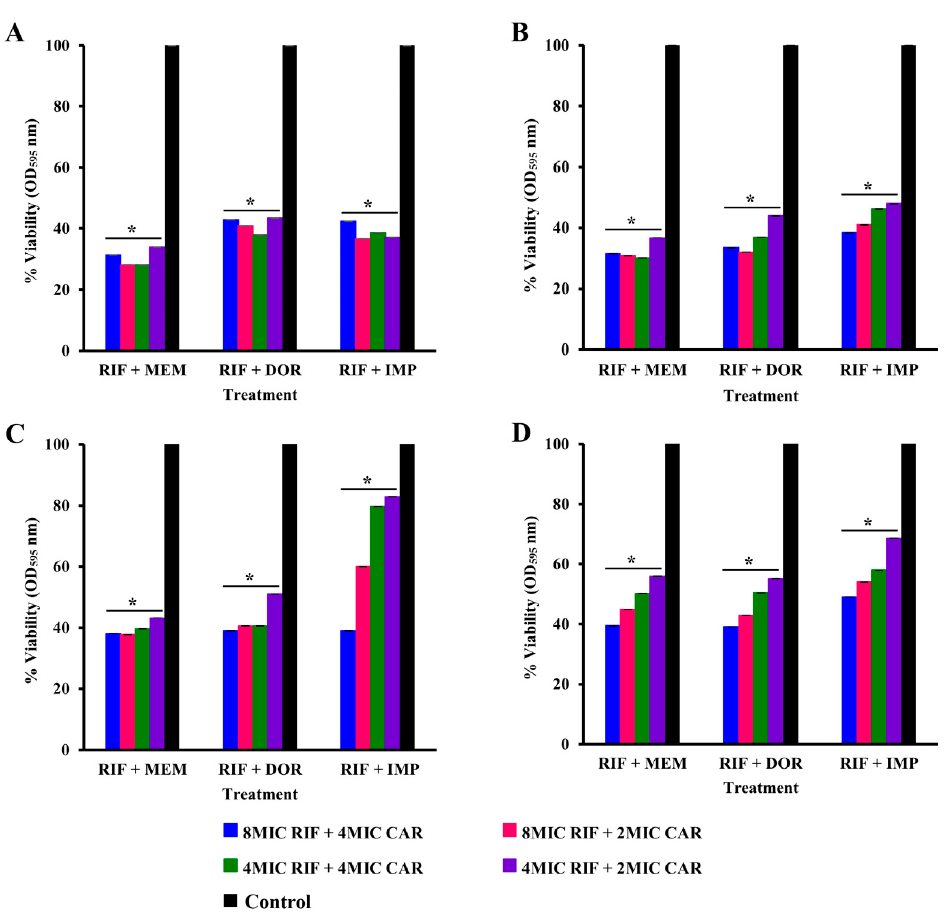
Figure 4. Cell viability of combination therapy against 96 h-established biofilm ( A ) SK015, ( B ) SK024, ( C ) TR125, and ( D ) TR045 expressed as percentage viability. MIC, minimum inhibitory concentration; RIF, rifampicin; MEM, meropenem; DOR, doripenem; IMP, imipenem; CAR, carbapenems. * p < 0.05.